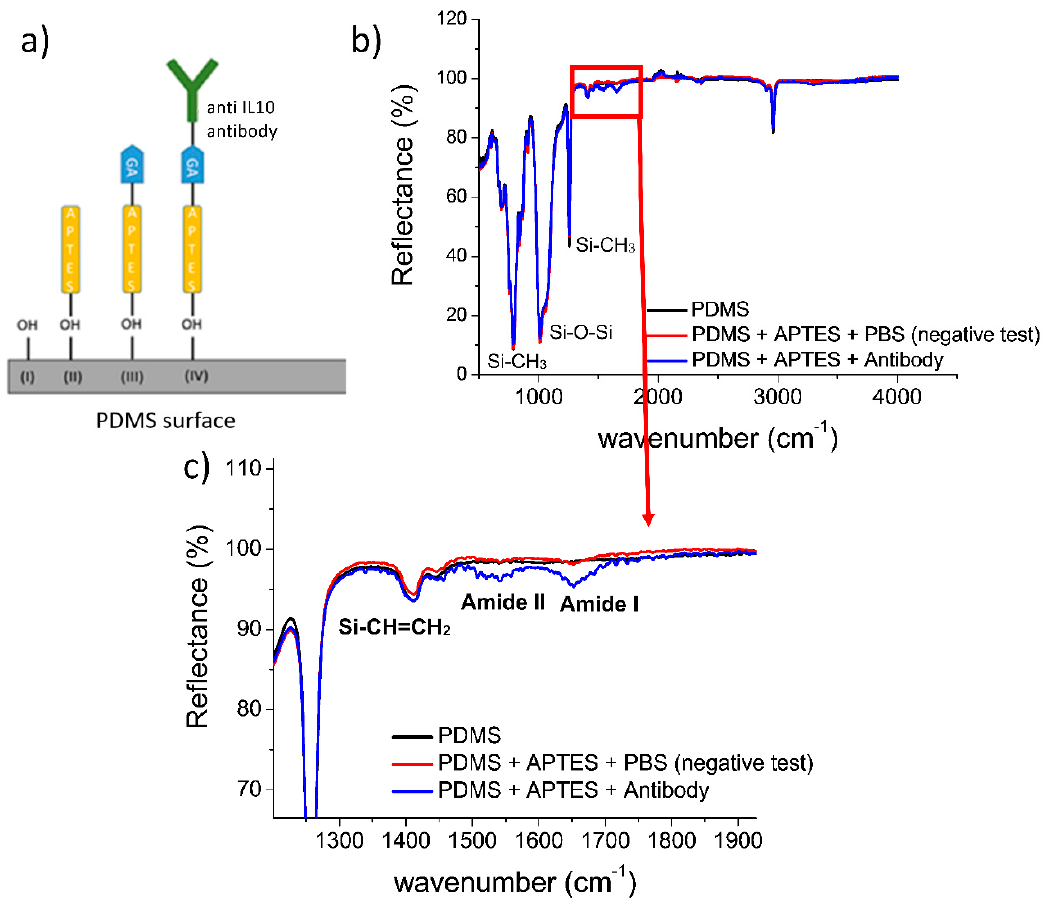
Figure 2. Antibody immobilization on PDMS: ( a ) scheme of the steps for functionalizing PDMS and glass with antibodies; ( b ) ATR-FTIR reflectance spectra acquired at different stages of the functionalization process; ( c ) detail of the reflectance ATR-FTIR spectra in the wavenumber range corresponding to amide I and II.